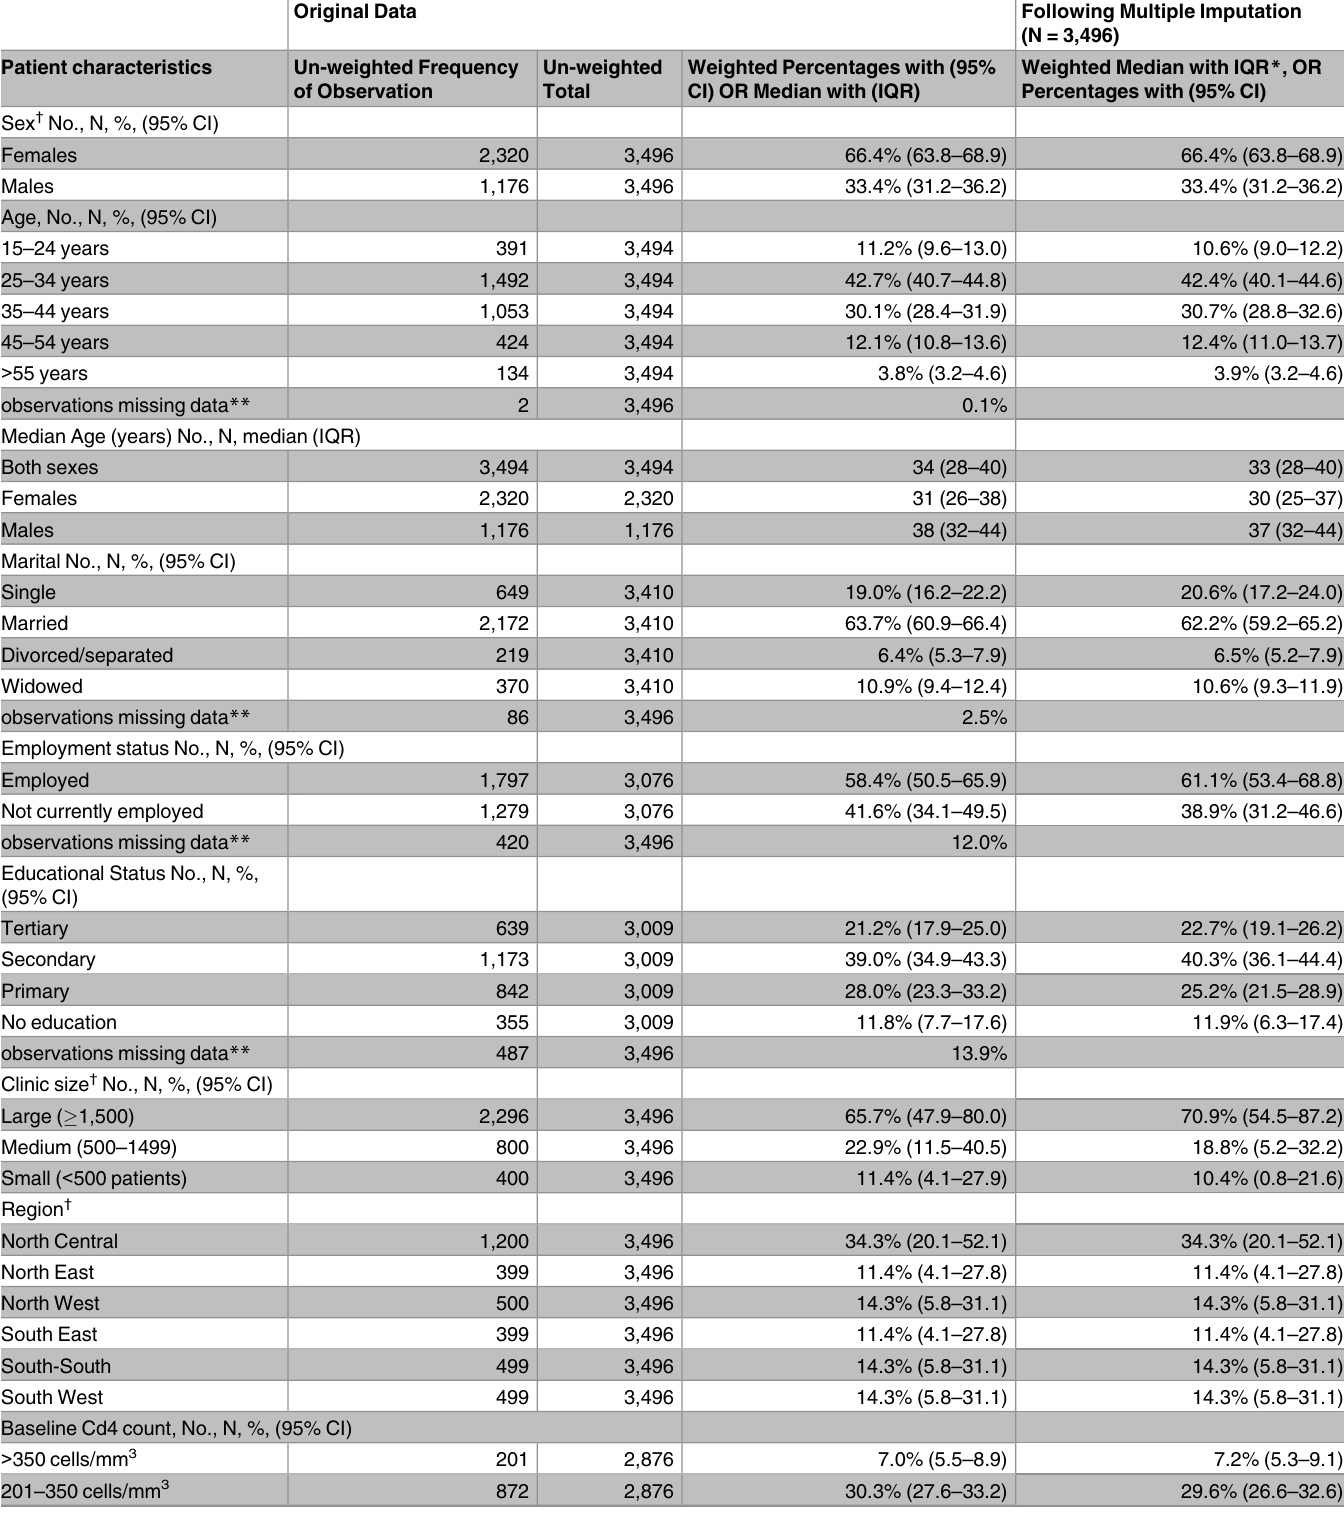
Table 1. Patients Sociodemographic and Clinical